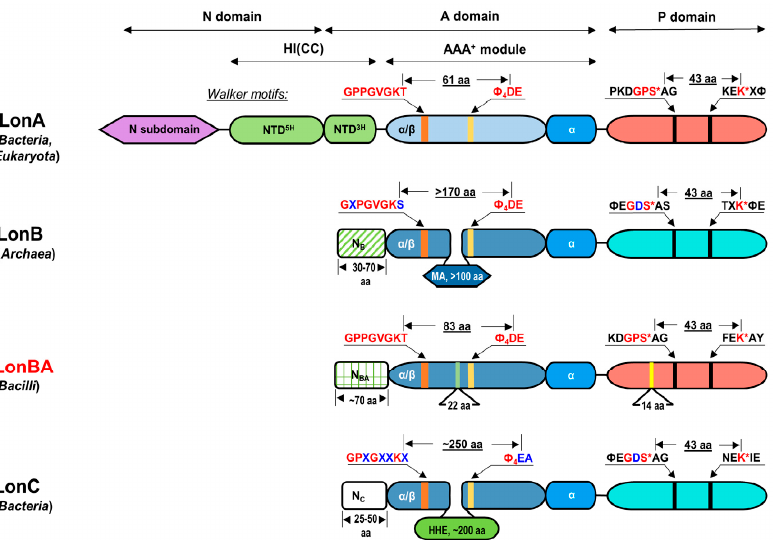
Figure 1. Schematic block diagram of the different subfamilies of Lon proteases. Corresponding functional domains that are more similar to each other are identified by the same color (light blue and blue colors of the α / β subdomains characterize A and B types of AAA + modules, respectively, whereas red and turquoise colors characterize the proteolytic (P) domains of A- and B-type). Con- sensus fragments of the AAA + modules and P domains crucial to the enzymatic activity are shown together with selected distances between them. Additional sequences in α / β subdomains in LonB and LonC (Membrane Anchoring Subdomain, MA, and Helical Hairpin Extension, HHE) are shown in blue and green, respectively. N B , N BA and N C are the N-terminal extensions in proteases of B, BA, and C subfamilies. The N-terminal region of LonAs is formed by three subdomains, with NTD 5H and NTD 3H forming the so-called helical insertion subdomain, HI(CC) [33] . Members of the LonA subfamily function in the cytoplasm of bacteria and in the mi- tochondria and chloroplasts of eukaryotes. In addition to the A and P domains, they also include an extended N-terminal region (Figure 1), which contains a fragment of a se- quence with a coiled-coil (CC) conformation. The LonB subfamily predominantly consists of membrane-bound Lon proteases of archaea, with the membrane-anchoring (MA) do- main embedded in the AAA + module (Figure 1) [30,31]. Crystal structures of the P do- mains of Ec LonA [34] and of Archaeoglobus fulgidus LonB ( Af LonB) [35] revealed their unique fold, highly conserved in both subfamilies [30]. However, although in each sub- family the catalytic Ser and Lys amino acids in the P domains are separated by exactly 42 residues, an important distinction is the presence of a Pro residue before the catalytic Ser in LonA enzymes, whereas the corresponding residue in LonB enzymes is invariably Asp. Based on unique features of the P domains of Lons observed in the crystal structures, Lon proteases were allocated to the SJ clan in the MEROPS peptide hydrolase database (https://www.ebi.ac.uk/merops/, accessed on 20 May 2022) [36]. Initially, the Lon family was divided into seven identification groups (ID). Bacterial and eukaryotic enzymes of ID groups 001-004 and 006 (75 members) had exclusively A-type active centers, and enzymes from archaea (ID group 005, 14 members) had B-type centers (Figure 1). Some Lon prote- ases with catalytic centers of both types were combined into a non-characterized ID group